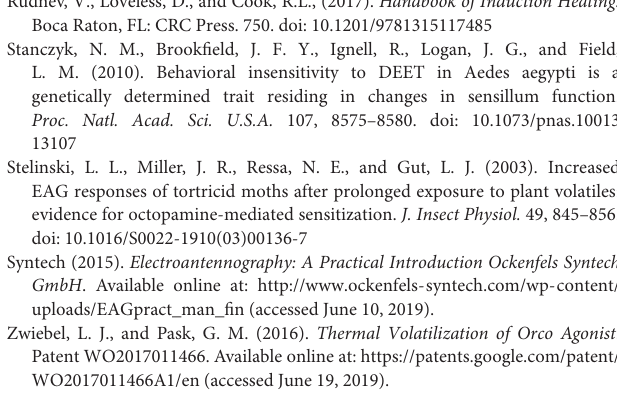
(white triangles in B ) wrapped around the alcohol thermometer, of the thermocouple coated with thermal grease (black triangles in A ), of a 20 gauge wire in contact with the thermocouple via heat-conducting grease (white circles in A ),